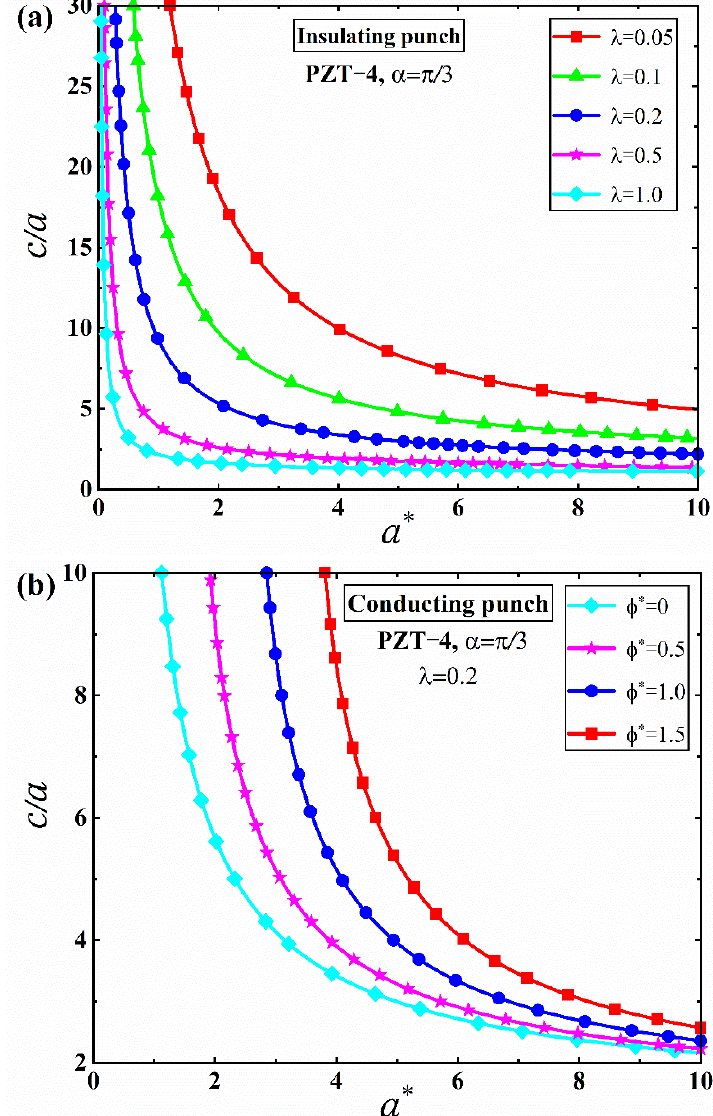
Figure 14. Variation of c / a with the dimensionless contact radius, a ∗ . ( a ) The effect of the transition parameter, λ . ( b ) The effect of the dimensionless electric potential, φ ∗